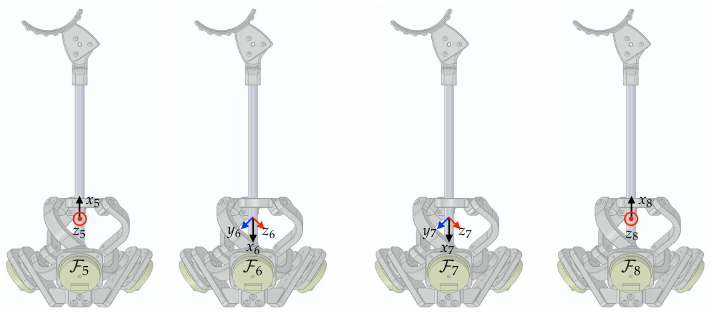
Figure 9. The frame assignments for the Agile Eye.